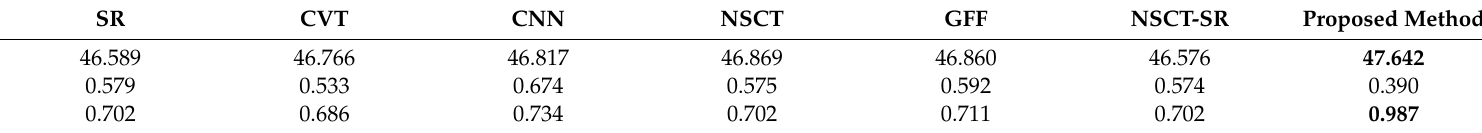
Table 10. The outcomes for the desk image and comparisons with existing techniques in the literature ([23]).